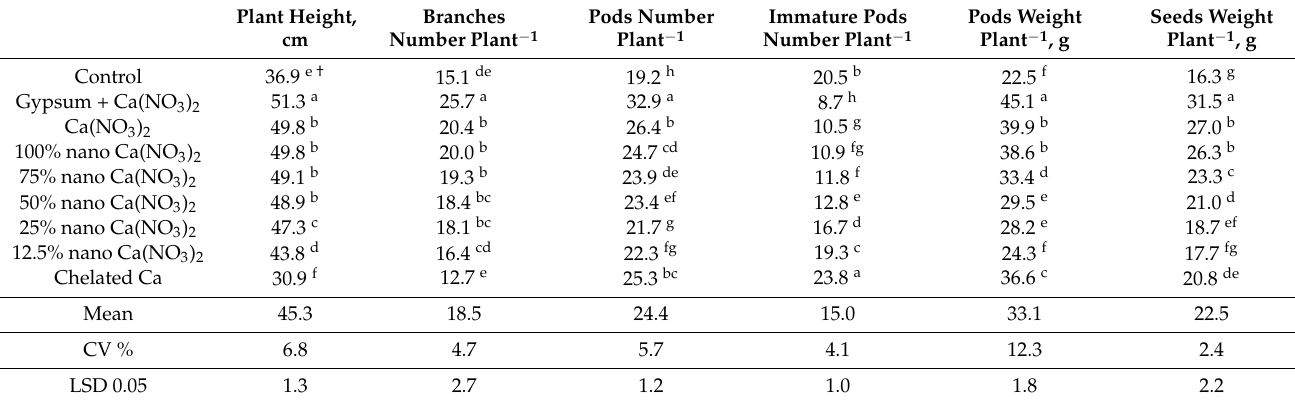
Table 5. Means of growth, yield components, and coefficient of variation (CV) of the peanut tested under calcium treatments in field experiments in Wadi El-Natroon, Egypt (combined data of the 2015 and 2016 seasons).